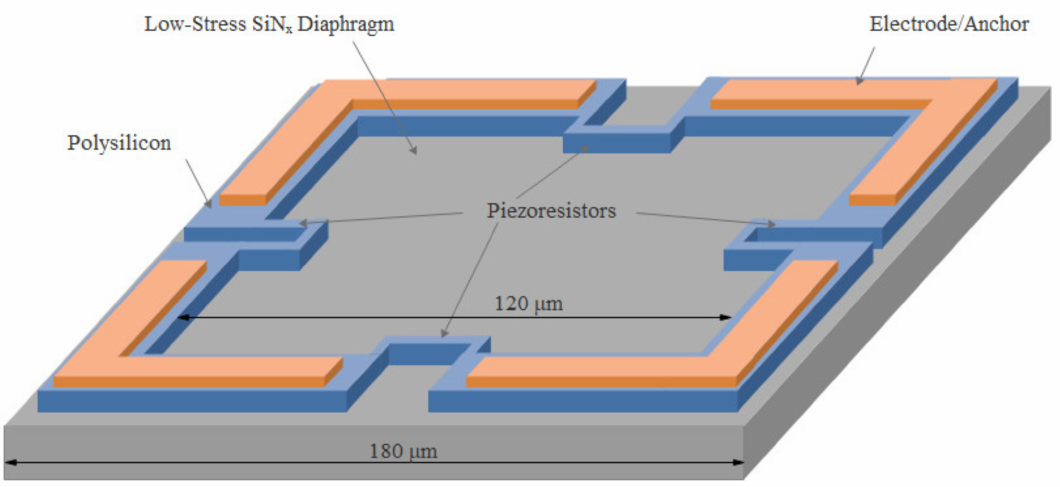
Figure 2. Schematic of the diaphragm of the normal force